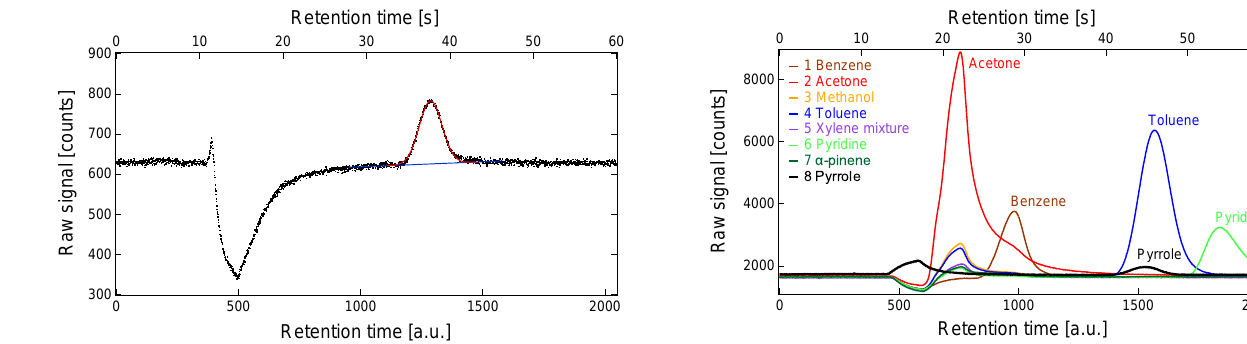
Fig. 2. Seven tested compounds (high ppbV to low ppmV levels) for interference on the pyrrole (black: 1000–2000a . u . ) retention time window. Four peaks are identified: acetone (red: 600–1000a . u . ), benzene (brown: 800–1200a . u . ), toluene (blue: 1300–1800a . u . ) and pyridine (green: 1700–2050a . u . ). Only toluene was overlap- ping with the pyrrole retention time window. Chromatograms for substances tested subsequently to acetone show a rest-acetone peak.